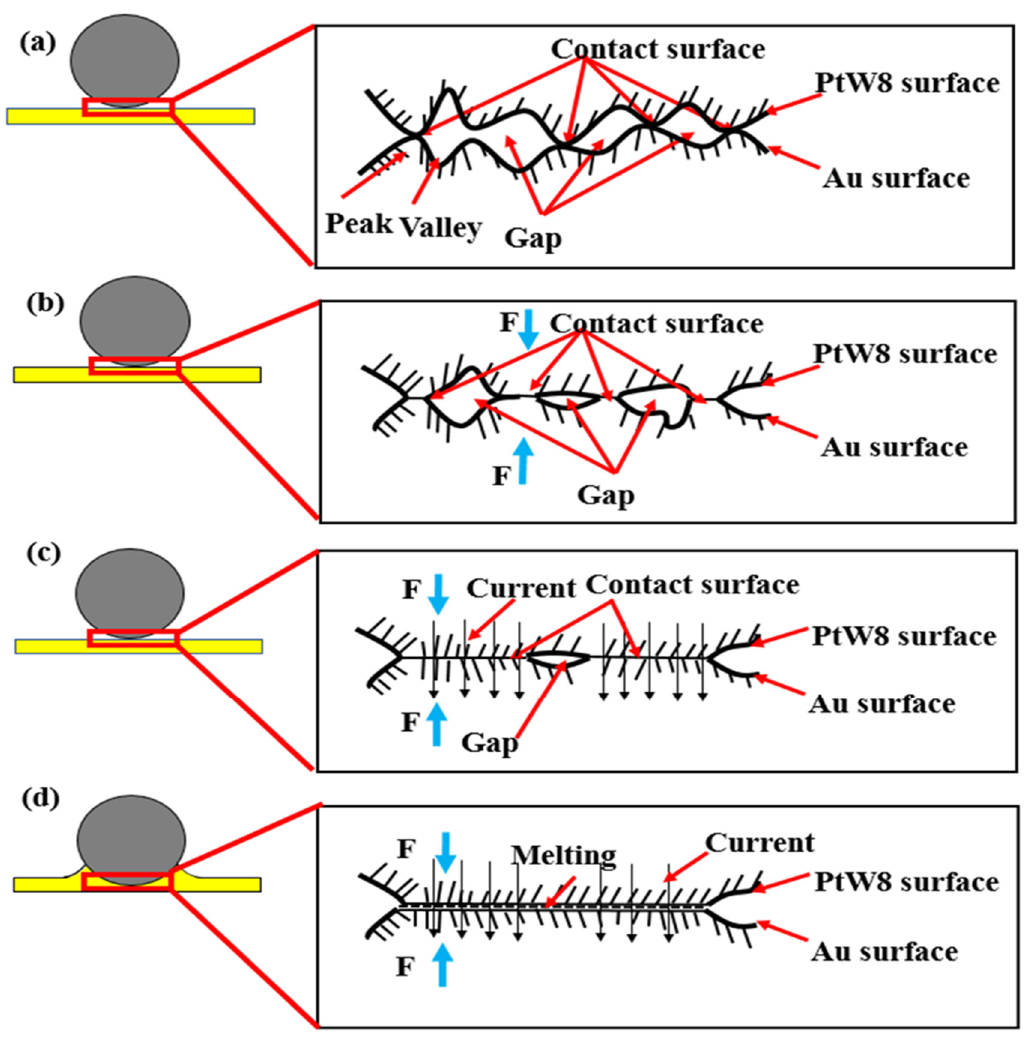
Figure 15. Schematic diagram of joint formation: ( a ) initial state, ( b ) deformation after pressing, ( c ) partial melting, and ( d ) molten metal wetting and spreading.